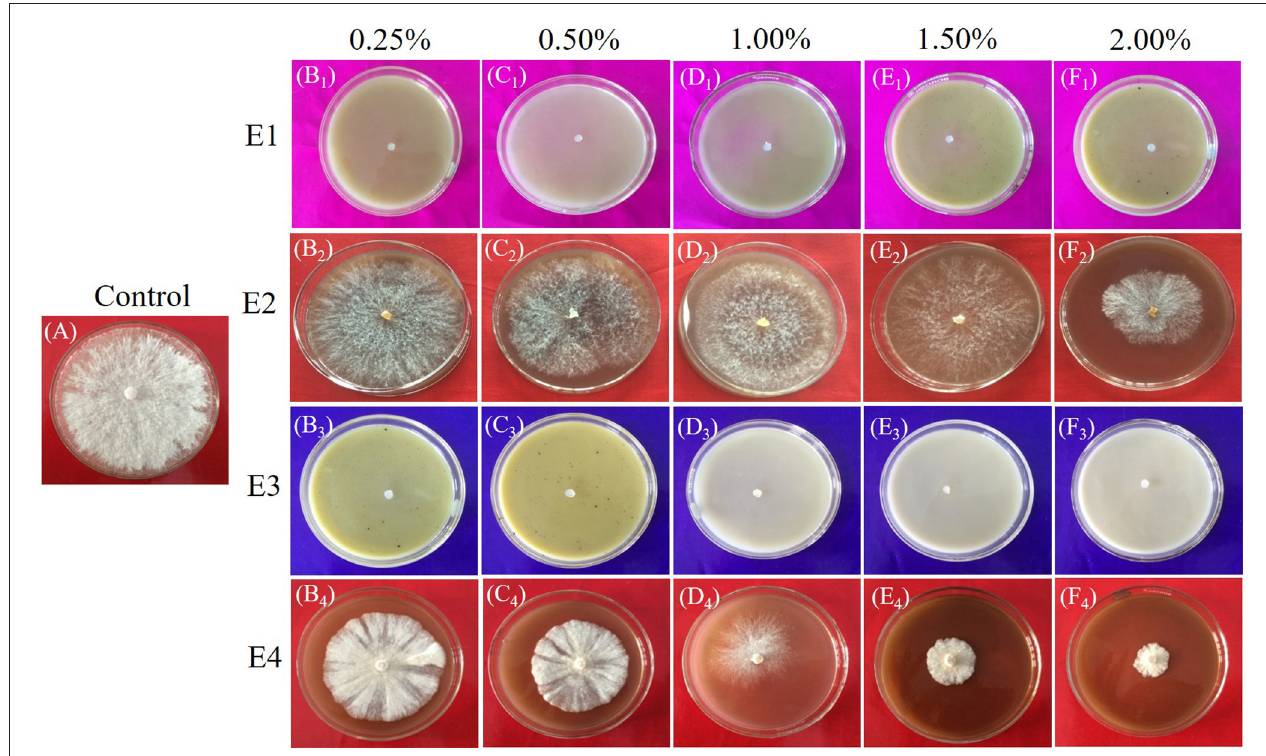
FIGURE 2 | (A–F) Antifungal activity of Laetiporus sulphureus against (A) Control (PDA + test fungi) and at 0.25, 0.50, 1.00, 1.50, and 2.00% concentrations of extracts (PDA + extracts + test fungi) E1 (B 1 -F 1 ) ; E2 (B 2 -F 2 ) ; E3 (B 3 -F 3 ) ; and E4 (B 4 -F 4 ) .